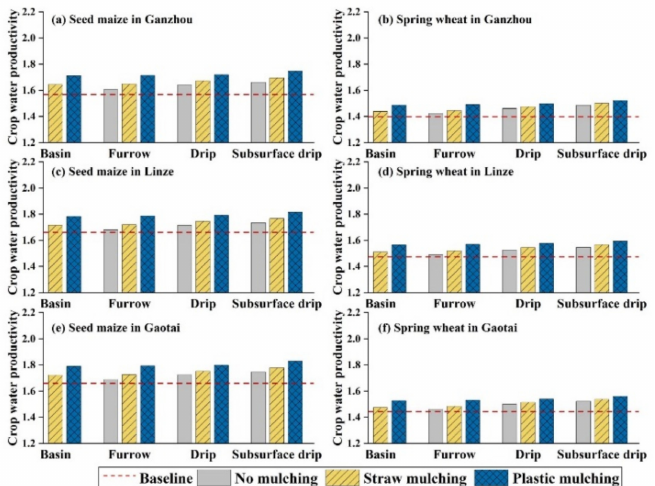
Figure 7. Crop water productivity (kg m − 3 ) of seed maize in ( a ) Ganzhou, ( c ) Linze and ( e ) Gaotai, and spring wheat in ( b ) Ganzhou, ( d ) Linze and ( f ) Gaotai under different combinations of management practices. (Baseline represents the combination of no mulching and basin